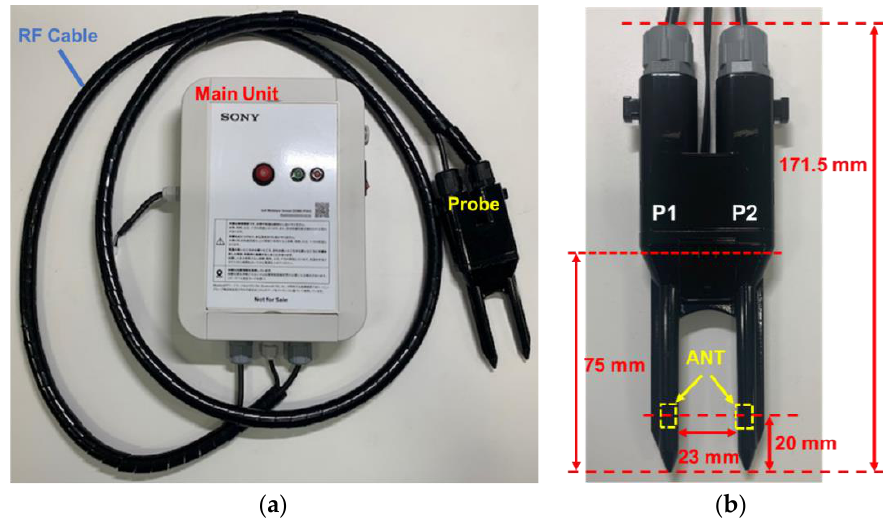
Figure 2. Prototype SFDT sensor: ( a ) SFDT sensor system and ( b ) SFDT sensor probe.